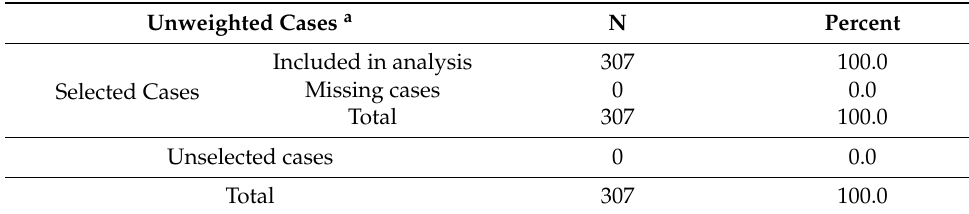
Table 12. Case processing